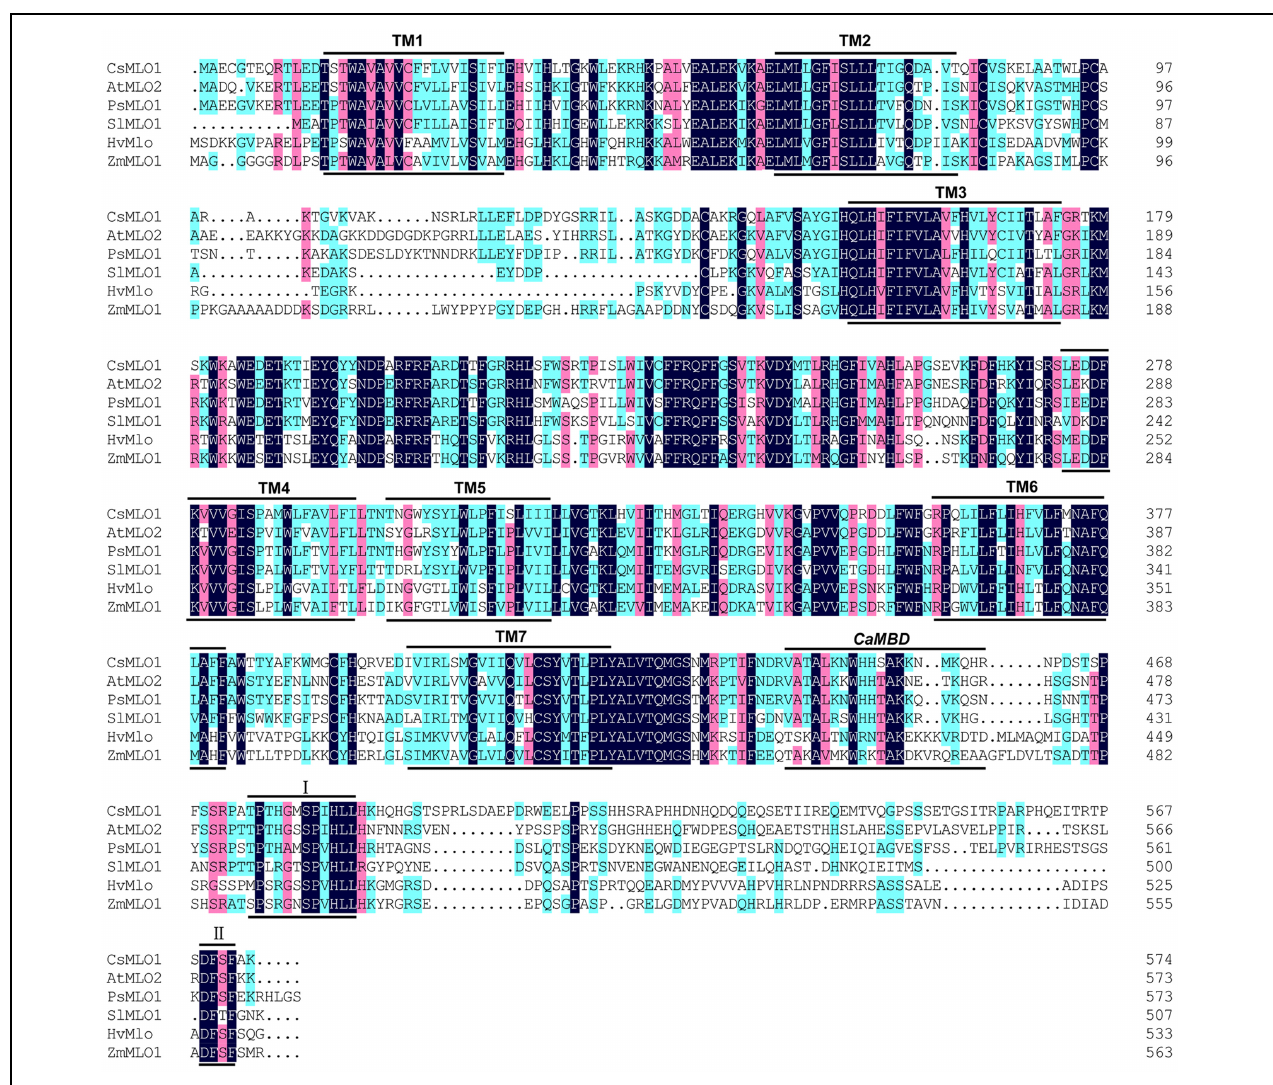
FIGURE 1 | Multiple amino acid sequence alignment of CsMLO1 and other MLO proteins. The amino acid sequences of HvMLO (barley), AtMLO2 ( Arabidopsis ), ZmMLO1 (maize), SlMLO1 (tomato), PsMLO1 (pea), and CsMLO1 (cucumber) were aligned with DNAMAN using the default parameters. The positions of the transmembrane regions (TM1–TM7) inferred from the experimentally determined topology of barley HvMLO (Devoto et al., 1999), the approximate position of the CaMBD (Kim et al., 2002a,b) and the other two conserved domains (I and II; Panstruga, 2005b) are indicated by lines above and below the aligned